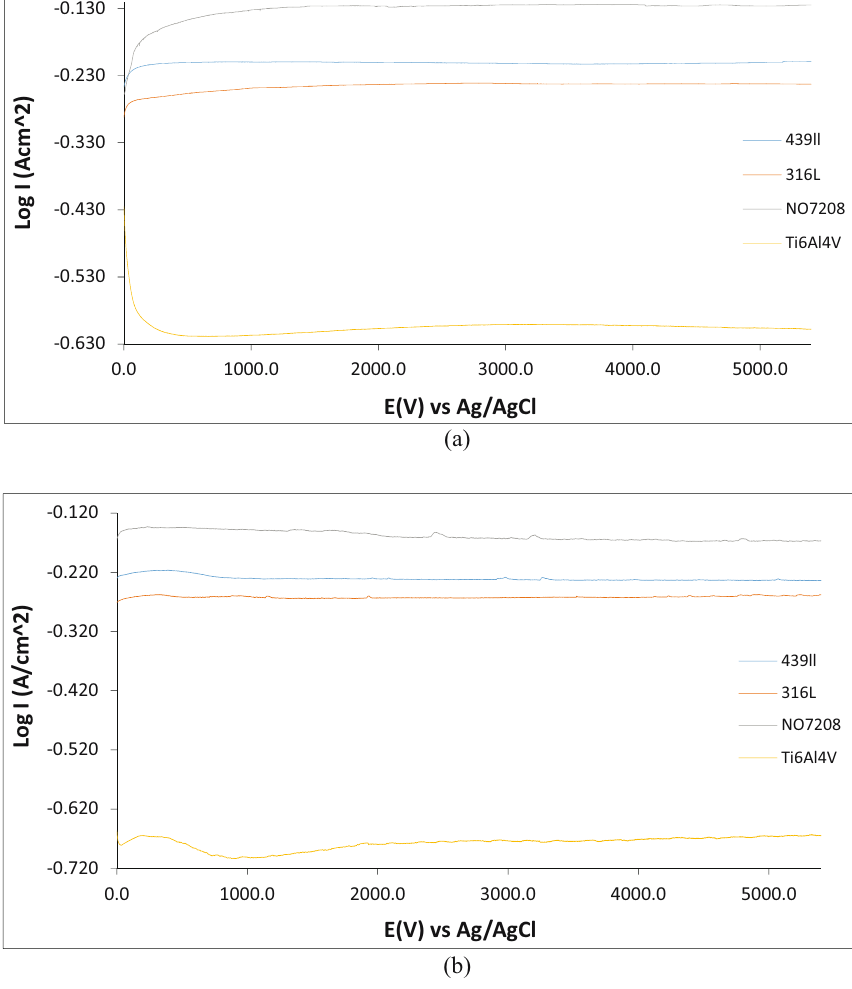
Figure 2: OCP plots of 439ll, 316L, NO7208, and Ti6Al4V alloys in 4 M H 2 SO 4 + 5% NaCl solution at ( a ) 35°C and ( b )